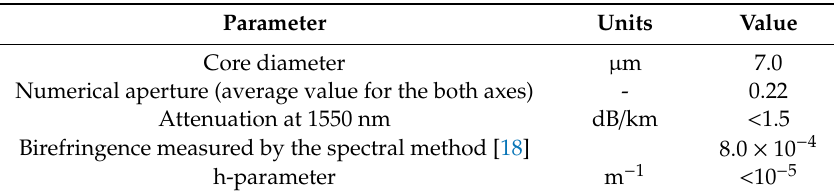
Table 1. Fiber under test parameters.